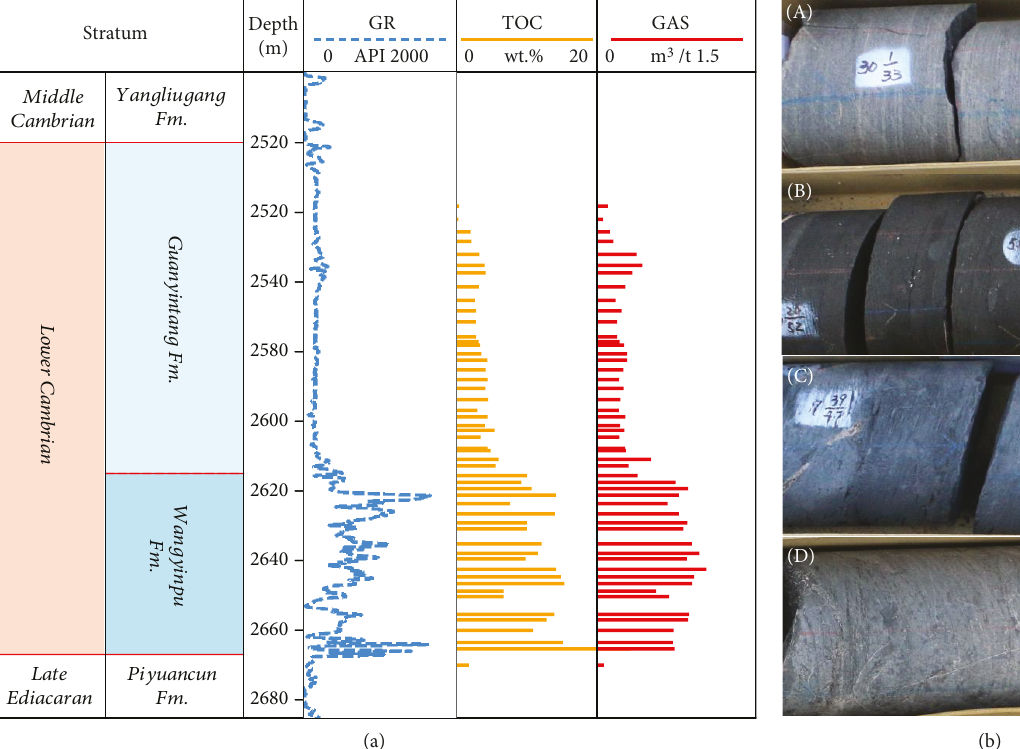
Figure 3: A stratigraphic column and core photos of the late Ediacaran and the lower-middle Cambrian of Jiangye-1. (A) The late Ediacaran Piyuancun formation (depth: 2675 m). (B) The lower Cambrian Wangyinpu formation (depth: 2638m). (C) The lower Cambrian Guanyintang formation (depth: 2546m). (D) The middle Cambrian Yangliugang formation (depth: 2511m). The data of gamma ray log and total gas content were from Schlumberger. See Figure 1 for the well location. Fm.=formation; GR =gamma ray log; TOC =total organic carbon content; GAS=total gas